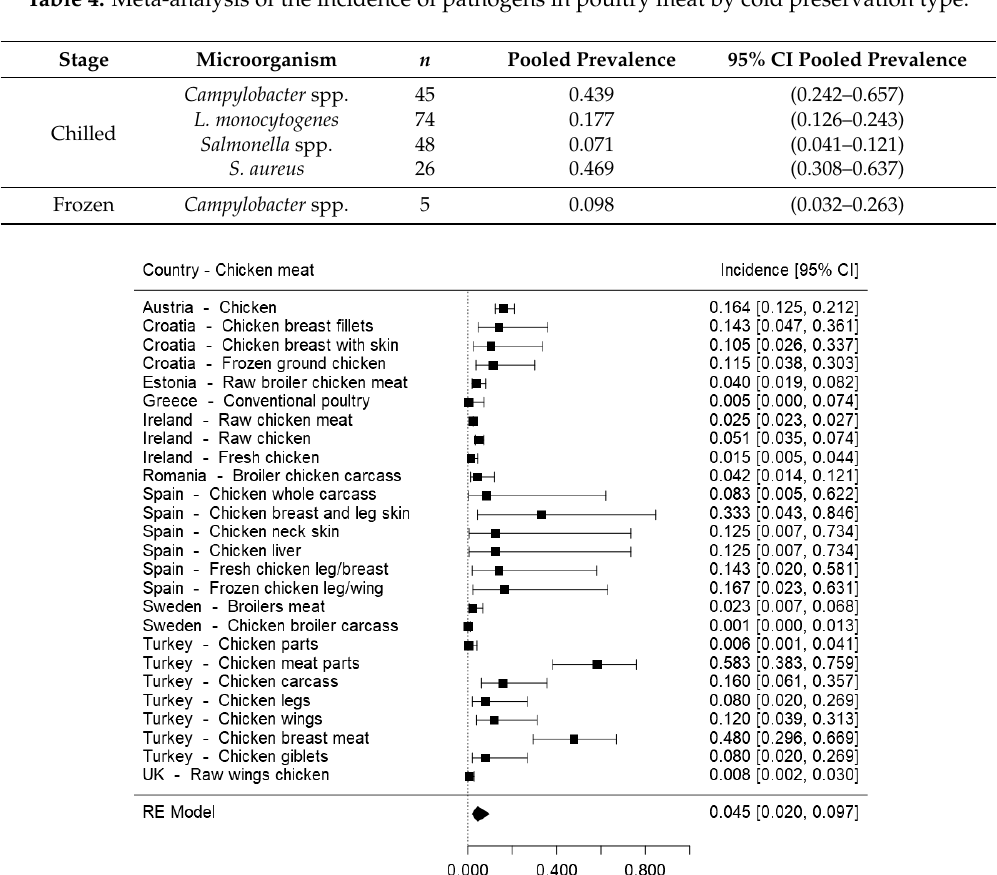
Figure 3. Forest plot of the incidence of Salmonella spp. in chicken meat surveyed in European establishments.